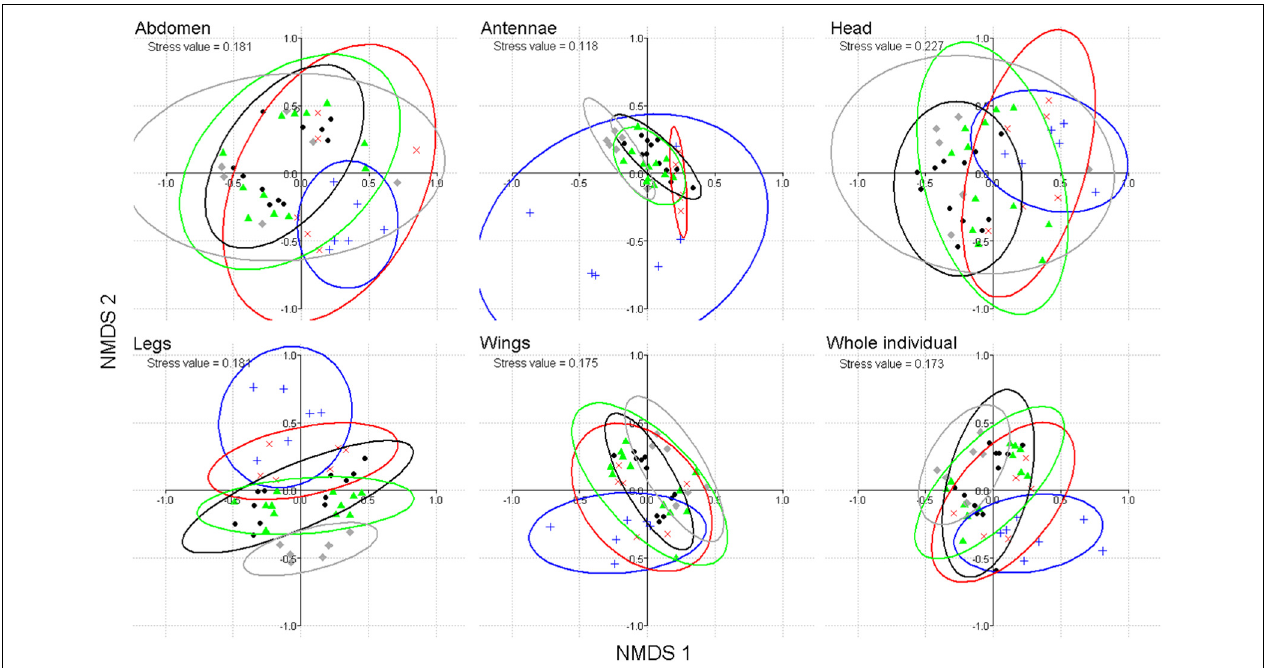
FIGURE 2 | Discrimination of B. anynana age classes (males and females) (1-day (blue), 3-day (red), 8-day (black), 14-day (green) and 21-day (gray) old) based on cuticular lipid composition (including the